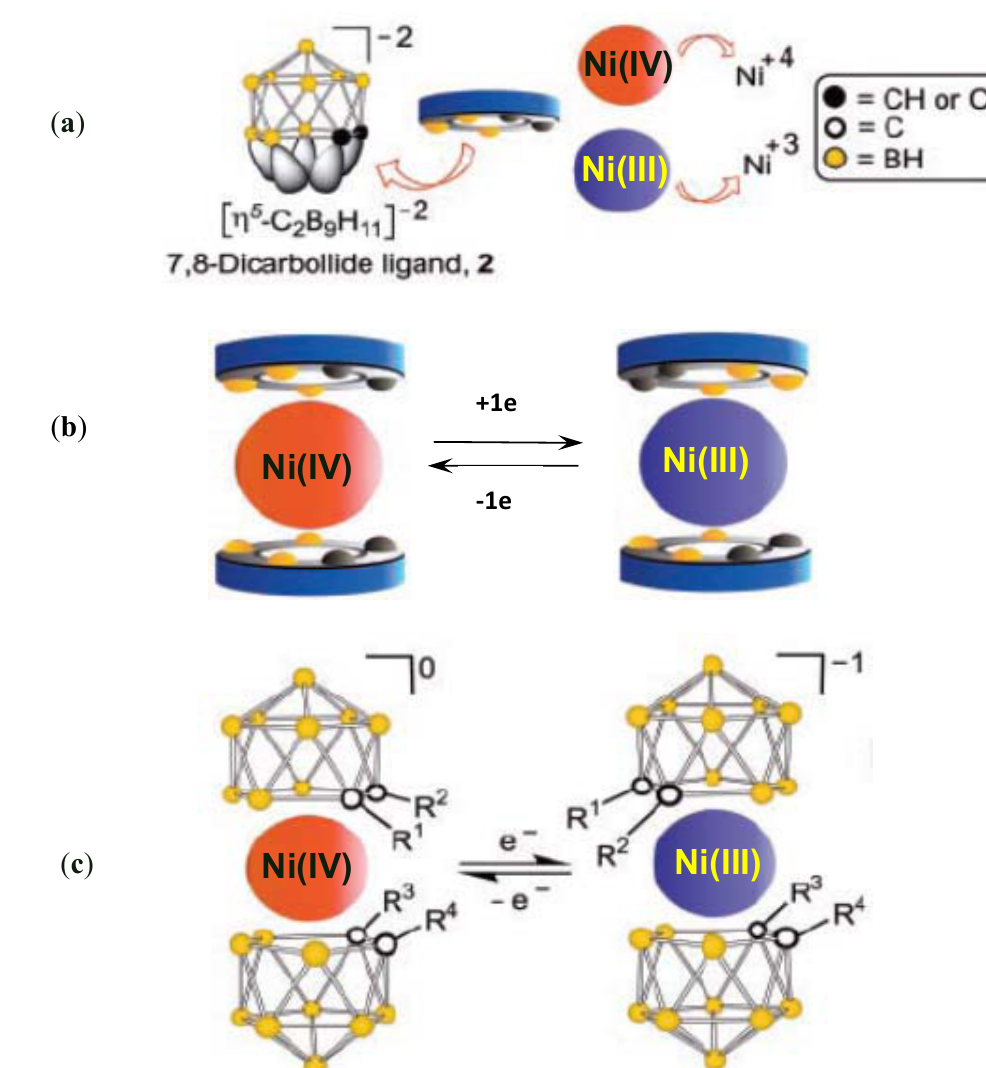
Figure 2. Illustration of rotor configurations of Ni(IV) and Ni(III) and the structural modules from which they are constructed. Structure Ni(III) is defined with rotation angle α = 0°. ( a ) Representative of each symbol in the schematic figure; ( b ) Schematic of the transition between Ni(IV) and Ni(III); ( c ) Detail structure of the transition between Ni(IV) and Ni(III). The diastereomers obtained by substitution of R for H at a single carbon vortex of the 7,8 ligands are meso (R 1 =R 4 =H, R 2 =R 3 =substituent) and dl (R 1 =R 3 =H, R 2 =R 4 =substituent and R 1 =R 3 =substituent, R 2 =R 4 =H; d and l assignments are arbitrary)